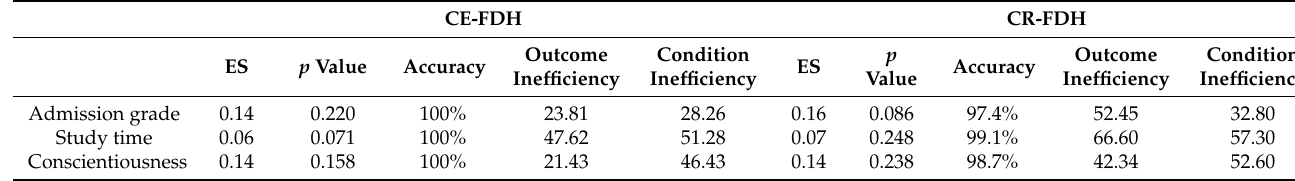
Table A2. NCA results with the complete data